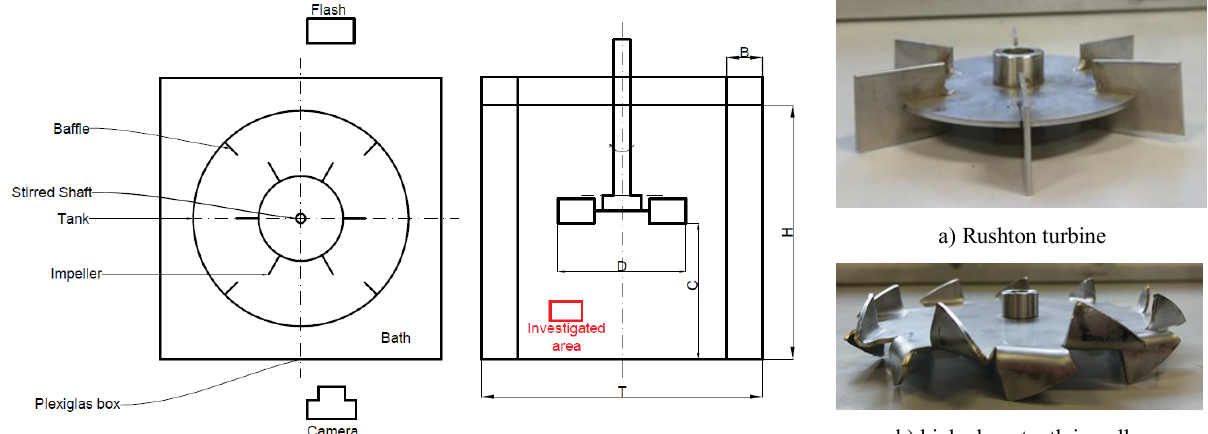
Fig. 1. Schema of experimental apparatus for image